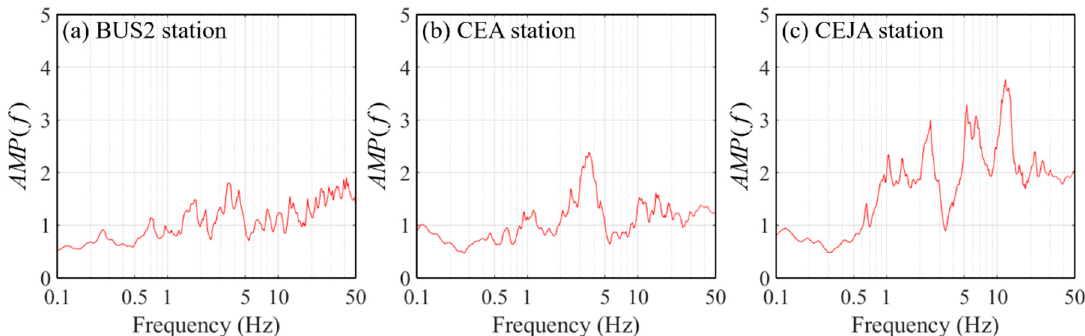
Figure 3. Site amplification factor function from the 2017 Pohang earthquake at sample stations: (a) BUS2 station, (b) CEA station, (c) CEJA station.